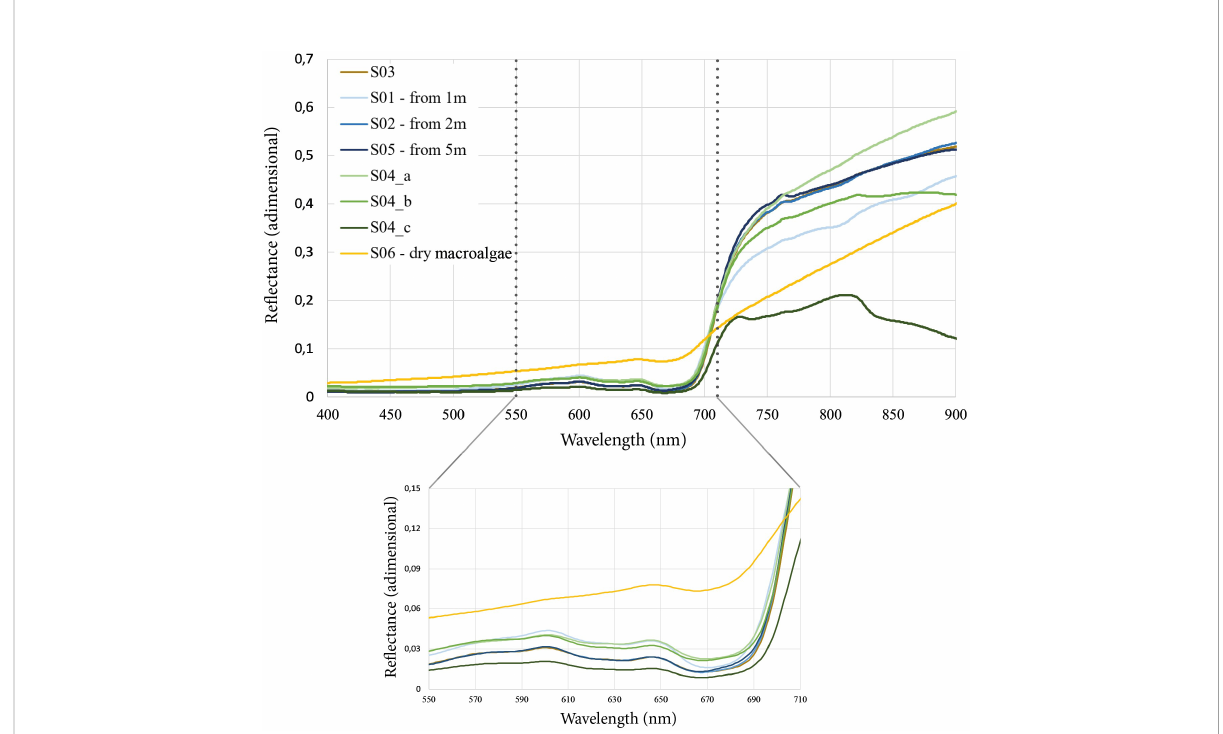
FIGURE 5 Re fl ectance of the sampled R. okamurae with the hyperspectral fi eld